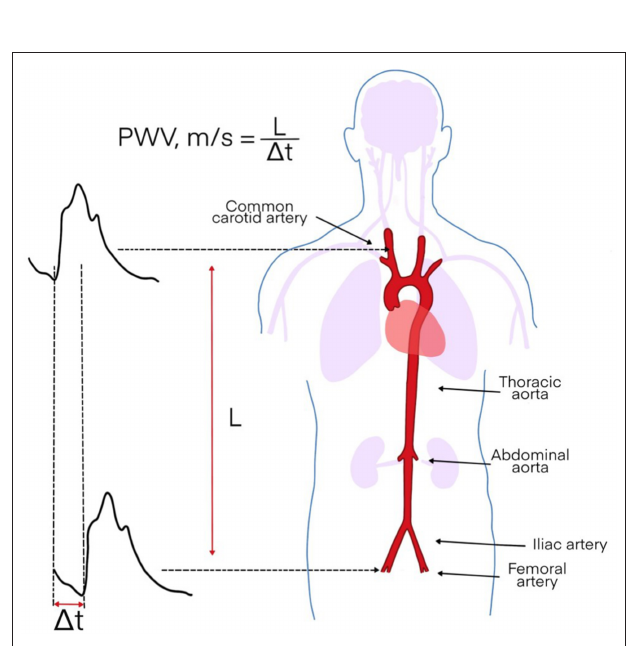
FIGURE 2 | Principles of assessment of pulse wave velocity